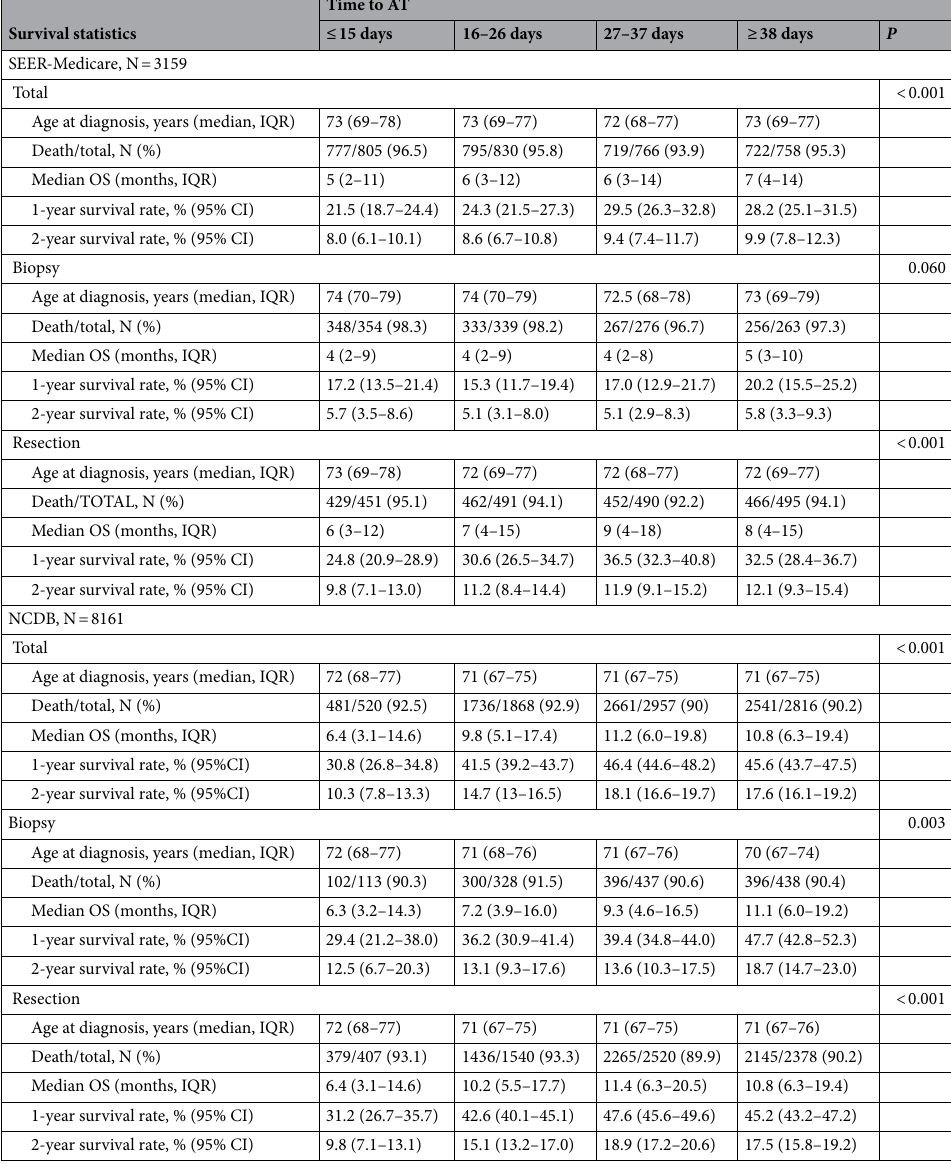
Table 3. Median OS, 1-year, and 2-year survival rates by time to AT and surgical procedure based on SEER-Medicare and NCDB. AT adjuvant therapy, OS overall survival, IQR interquartile range, 95% CI 95% confidence interval. The difference of Kaplan–Meier survival proportions across time to AT was tested by using two-sided log-rank